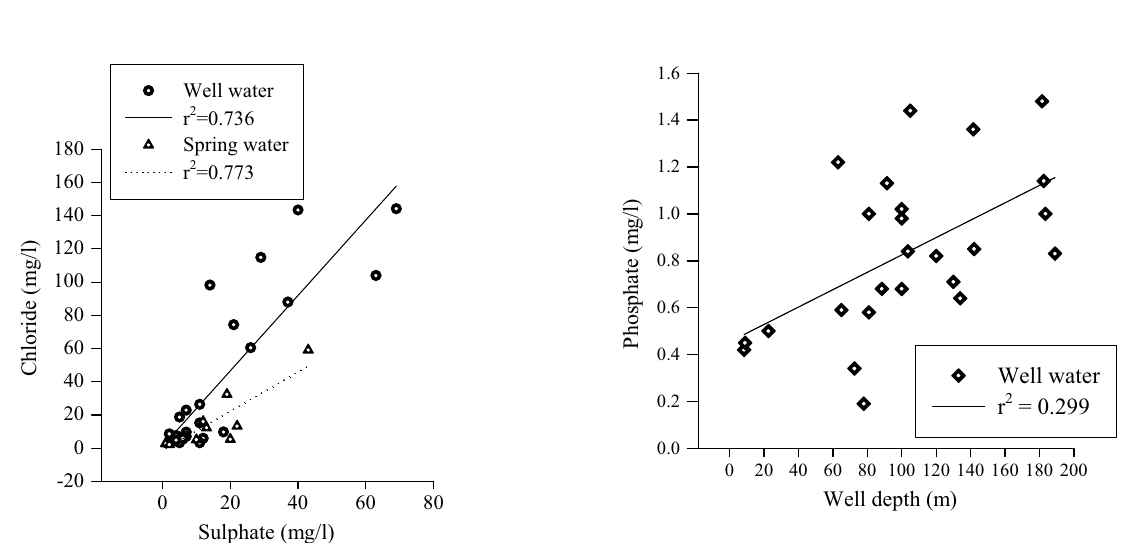
Fig. 6 Scatter plot for sulfate and chloride